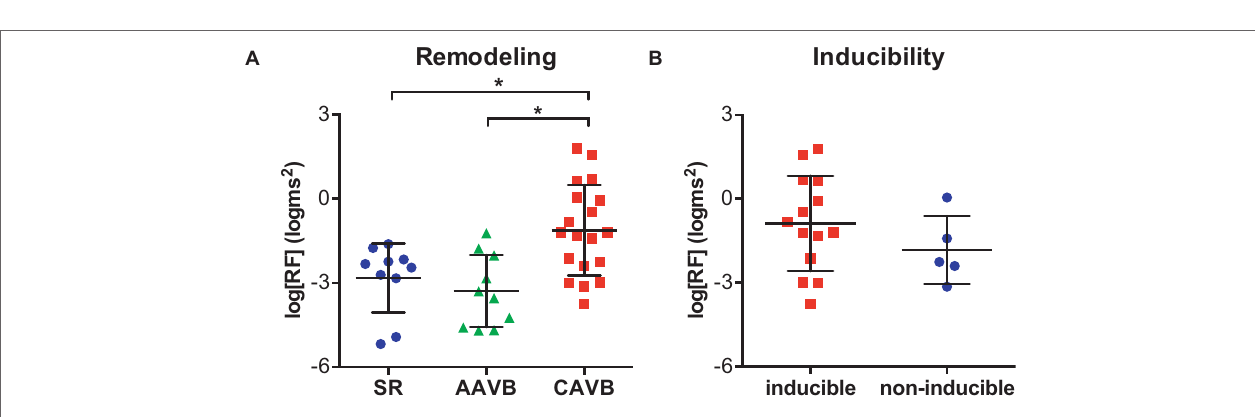
FIGURE 2 | Respiratory oscillations of monophasic action potential duration. (A) The logarithmic transformed power of respiratory oscillations of APD (log[RF]) at sinus rhythm (SR), acutely after AV block (AAVB), and at chronic AV block (CAVB). (B) log[RF] of the inducible vs. the non-inducible CAVB dogs. * p <